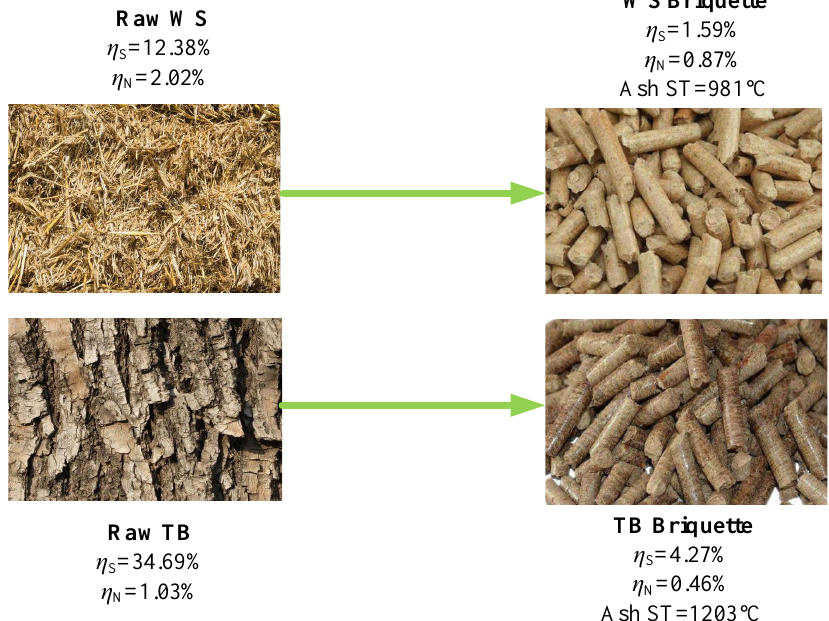
Figure 1. Diagram of Tree Bulk (TB), Wheat Straw (WS) and their briquettes.